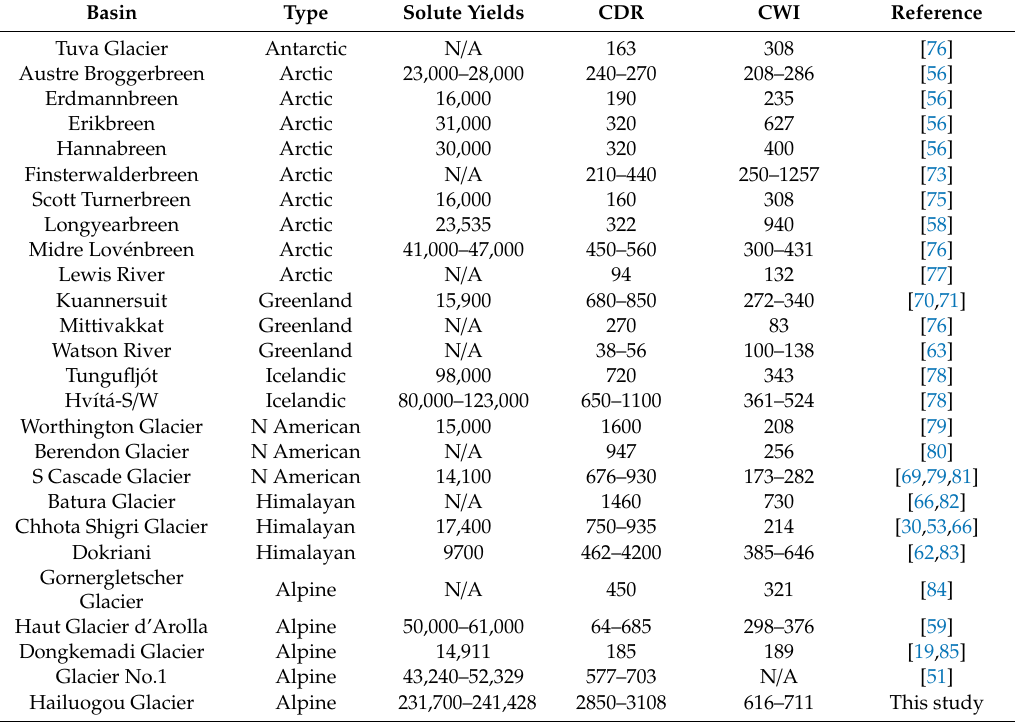
Table 5. The solute yields (kg · km − 2 · year − 1 ), cationic denudation rate (CDR; Σ *meq + · m − 2 · year − 1 ) and chemical weathering intensity (CWI; Σ *meq + · m − 3 · year − 1 ) at the Hailuogou basin, in comparison to other glacial basins worldwide. N / A denotes data are not available.